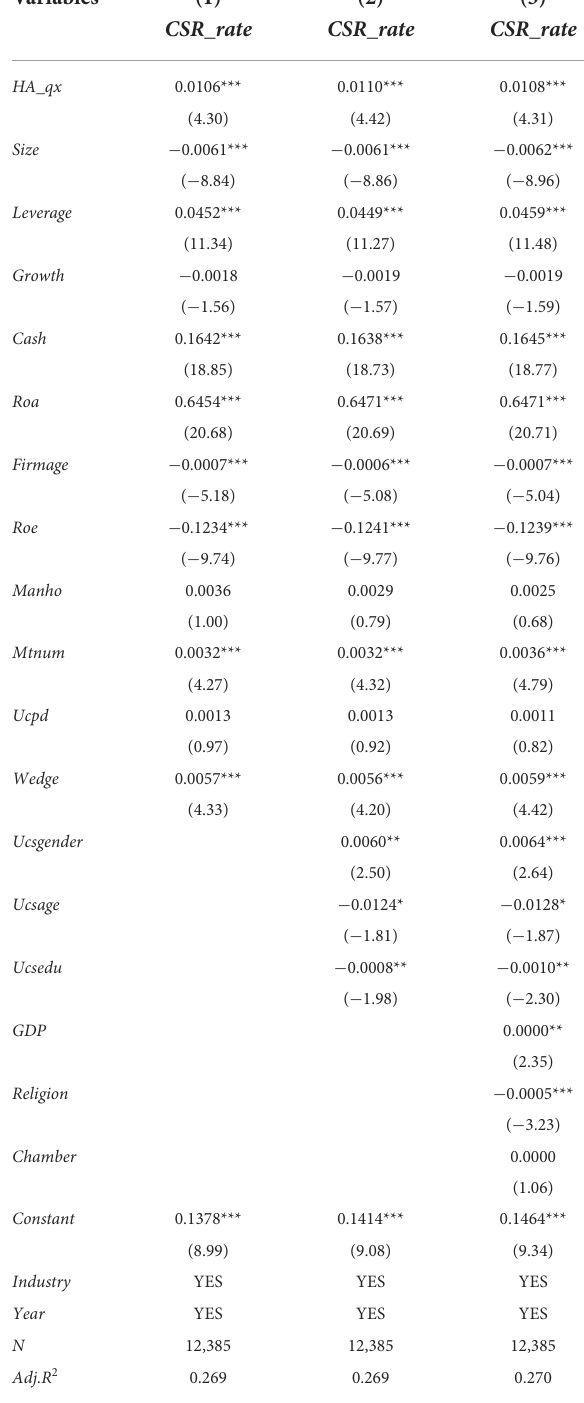
TABLE 6 The effect of the ultimate controller’s HA on CSR